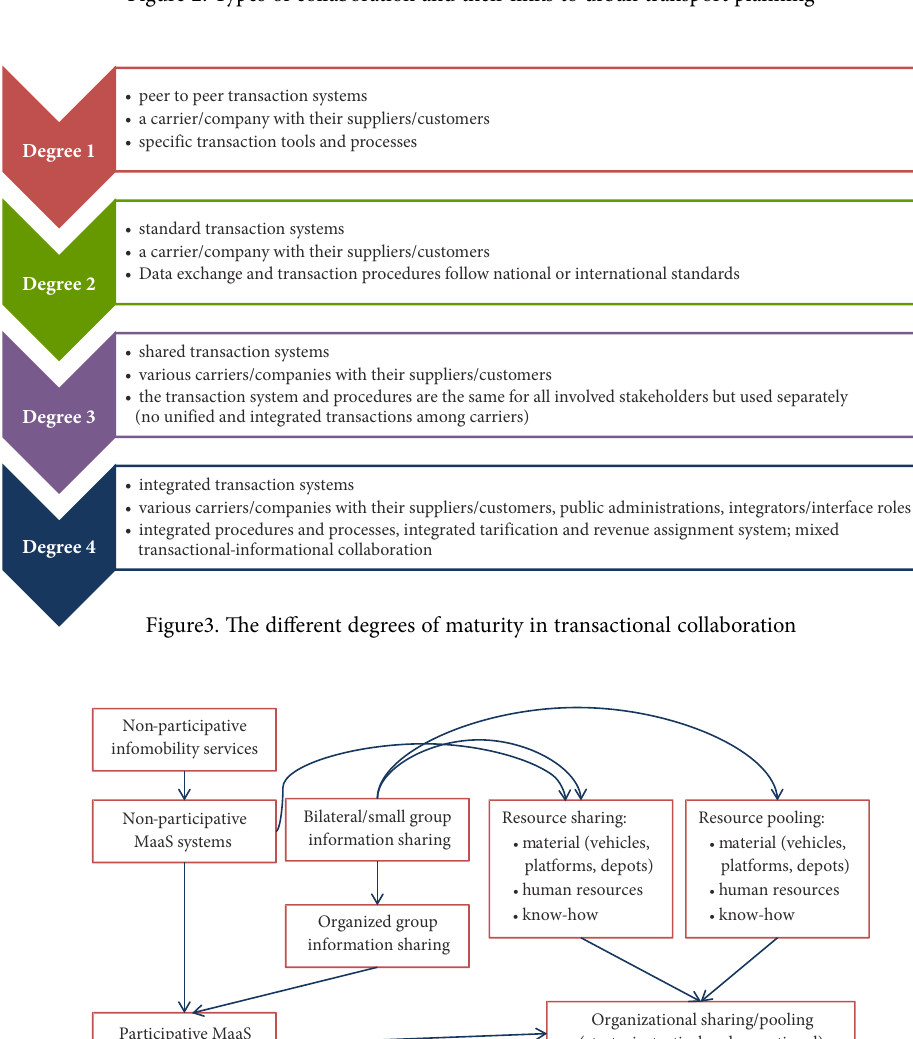
Figure 2. Types of collaboration and their links to urban transport planning